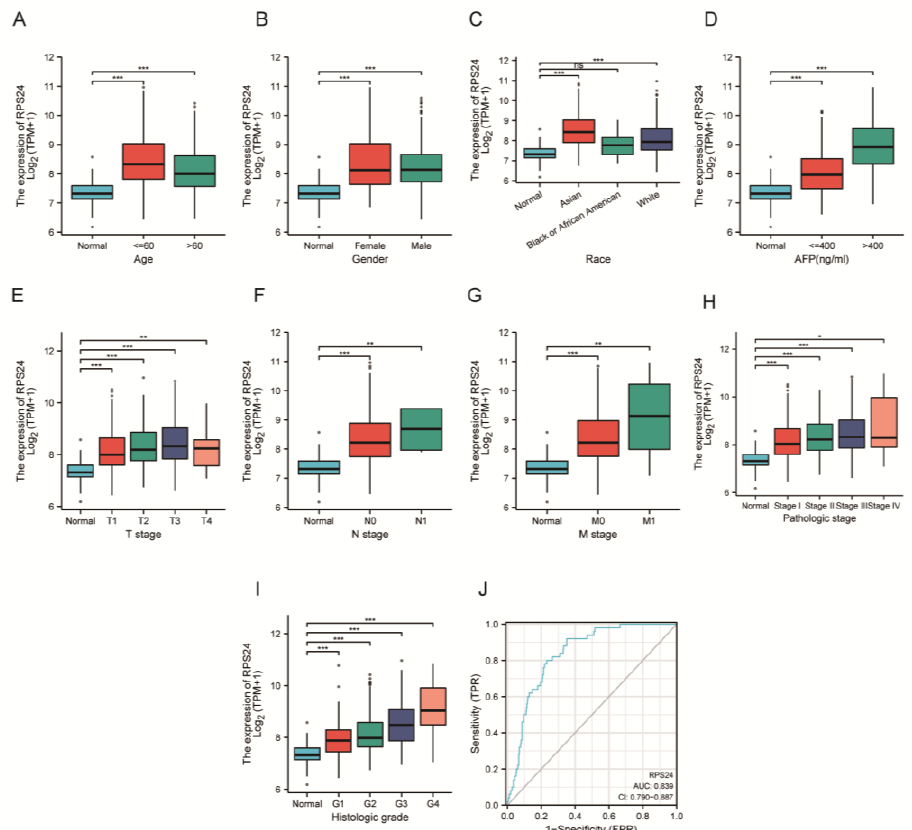
Figure 2. RPS24 mRNA expression in patients with different clinicopathological features. ( A – I ) Comparison of RPS24 expression in normal liver tissue and cancer tissue with various clinicopathological features, including age, sex, pathological stage, lymph node metastasis, distant metastasis, histological grade, race, and AFP was performed using the TCGA-LIHC dataset. ( J ) The diagnostic value of RPS24 expression in normal individuals and cancer patients was performed using the TCGA-LIHC dataset. ns p ≥ 0.05; * p < 0.05; ** p < 0.01; *** p < 0.001.